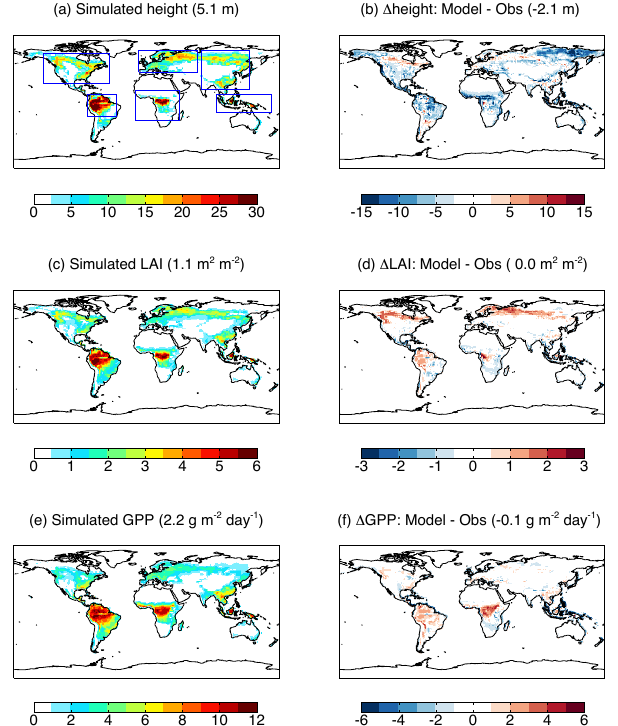
Figure 5. Simulated (a) tree height, (c) LAI, and (e) GPP and their differences relative to observations (b, d, f) . GPP data set is from Jung et al. (2009). Simulations are performed with WFDEI reanaly- sis. Statistics are the annual average for the period 1982–2011. The boxes in panel (a) represent six regions used for seasonal compari- son in Fig.